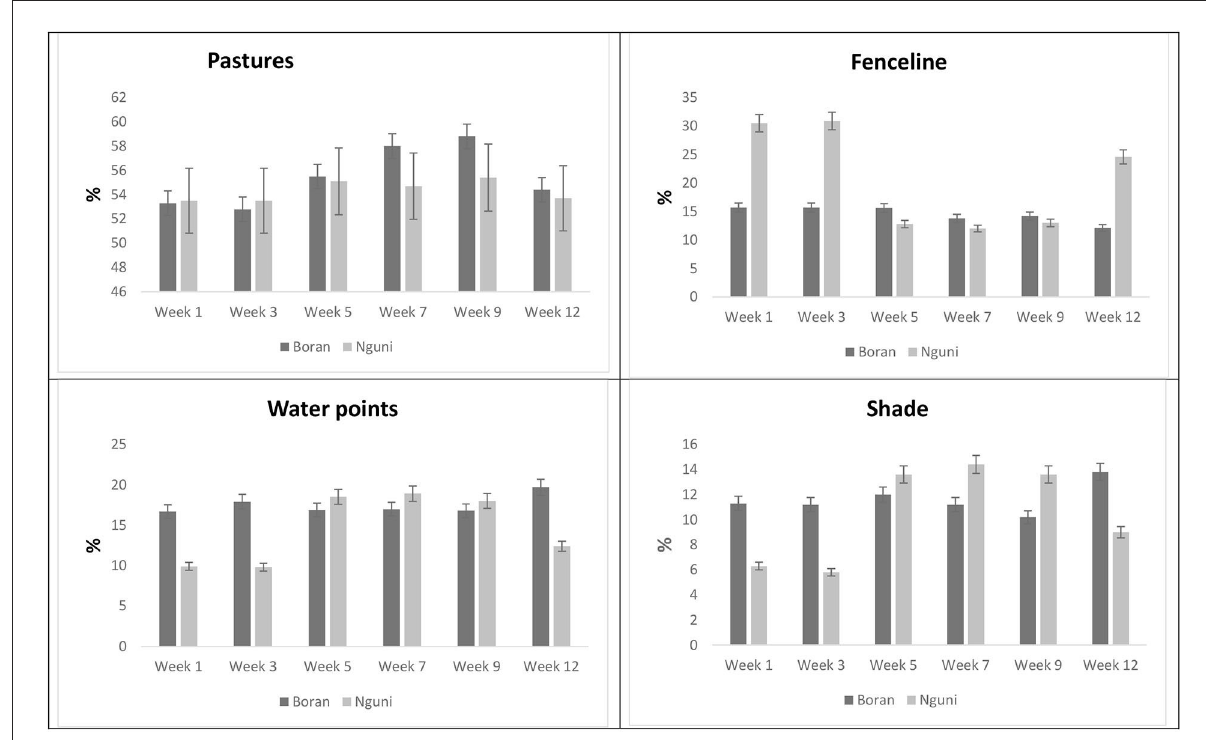
FIGURE2 LSMeans for the number and duration of drinking bouts according to breed during the observation period.